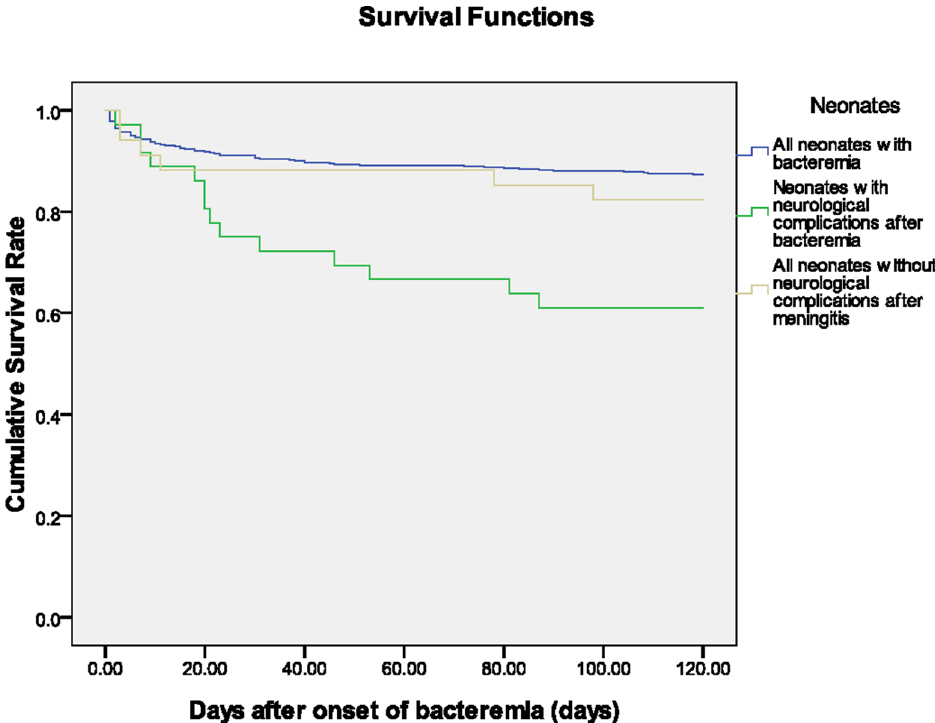
Figure 2. The Kaplan-Meier survival curve of neonates with bacteremia-related neurological complications (BNCs), and those discharged in a critical condition after withdrawing life-sustaining treatments were considered dead at the day of discharge.